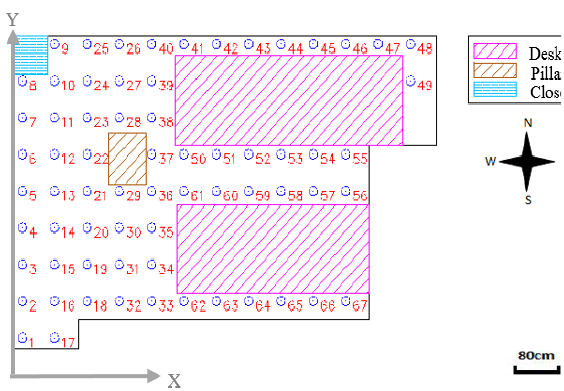
Figure 5. The plan of selected study area